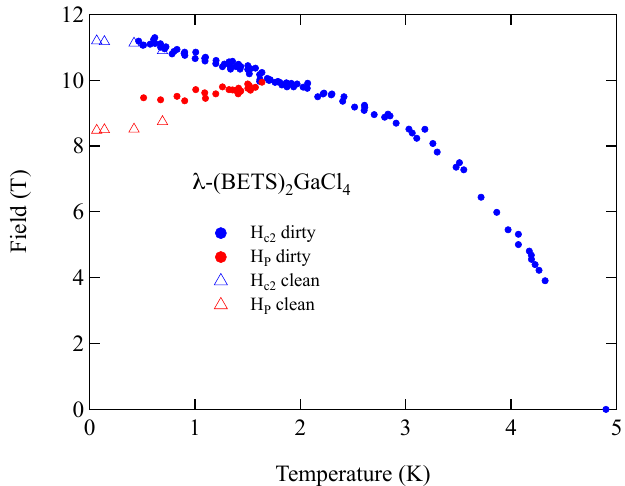
Figure 7. We obtained new samples from Kobayashi that are higher quality samples (more pure) based on Shubnikov–de Haas oscillations. The higher quality samples show on an absolute scale that the upper critical field of the clean and dirty samples is the same, but H P is very sensitive to impurities. The new data was taken in a dilution refrigerator and we are looking forward to extending the data to higher temperatures in the near future.